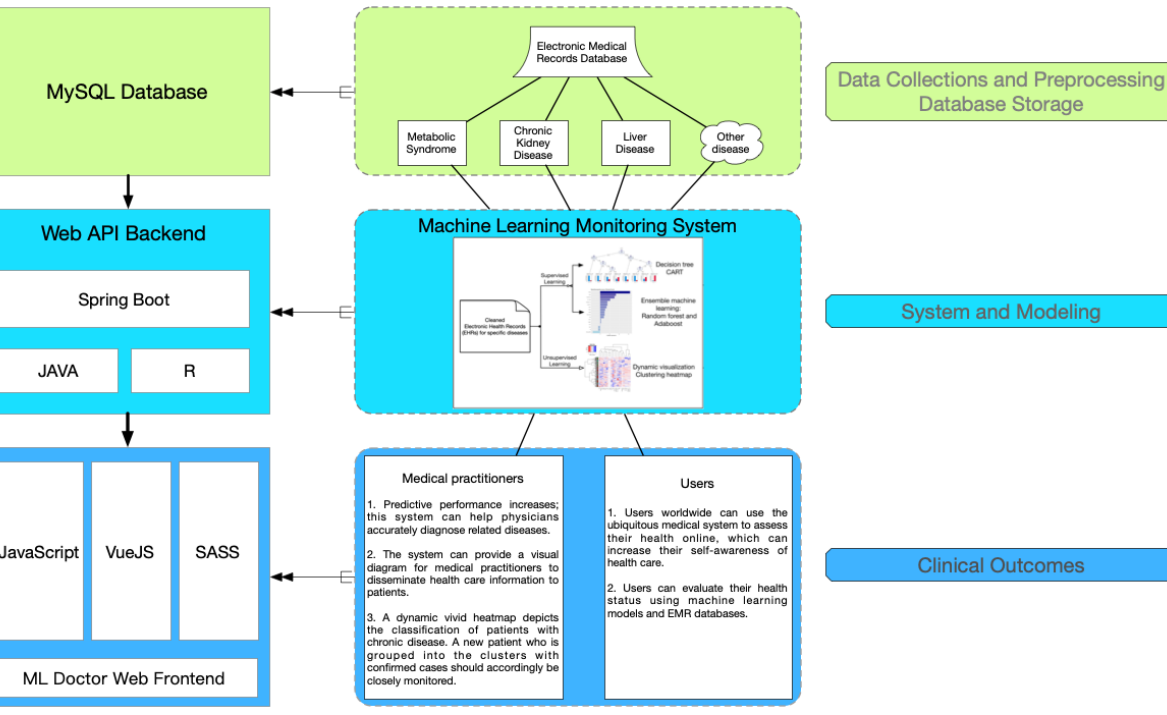
Figure 1. The structure of web-based machine learning medical system. API: application programming interface; EMR: electronic medical record; ML: machine